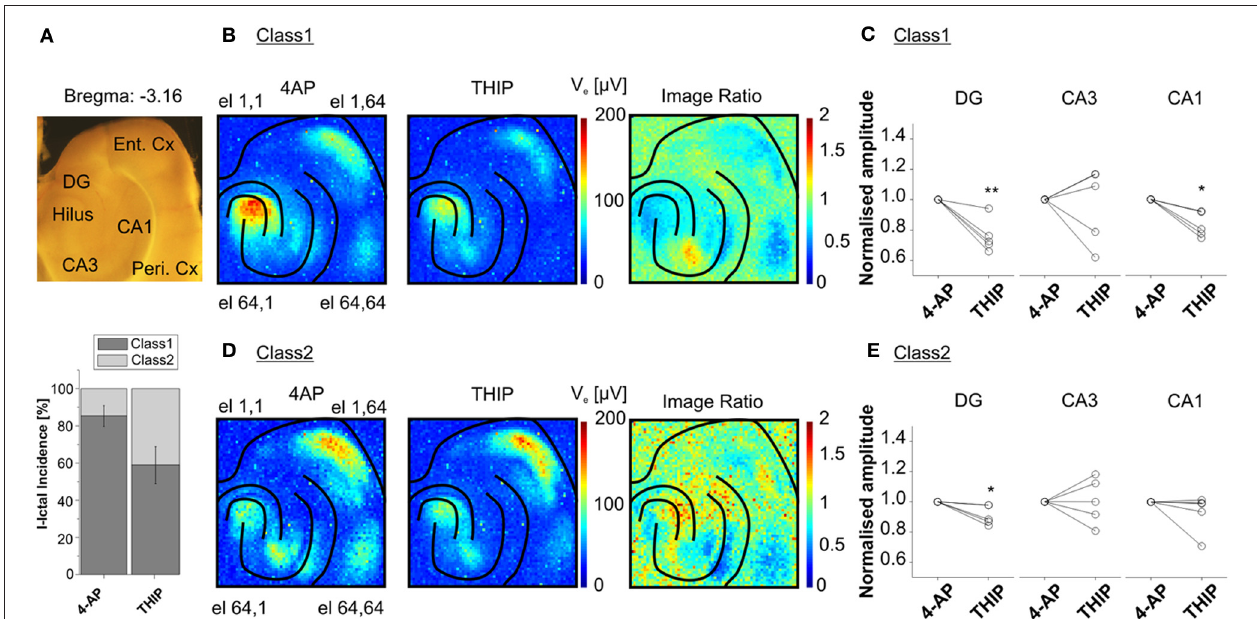
FIGURE 8 | Classification of I-IC events. Classification of I-ICs from five experiments reveals that two main classes of I-IC can be identified based on the spatial dissection of the I-ICs (recordings of 20min. per phase, ∼ 30 total events per phase). Class 1 clusters events originating in CA3 and propagating to other regions of the hippocampus and to the EC, whereas Class 2 clusters events originating in the EC and propagating to the hippocampus. (A) On the top, view of the cortico-hippocampal slice over the chip; on the bottom, incidence of the two detected classes over the five different experiments upon treatment with 4AP and THIP. (B, D) Average of the maximal amplitude